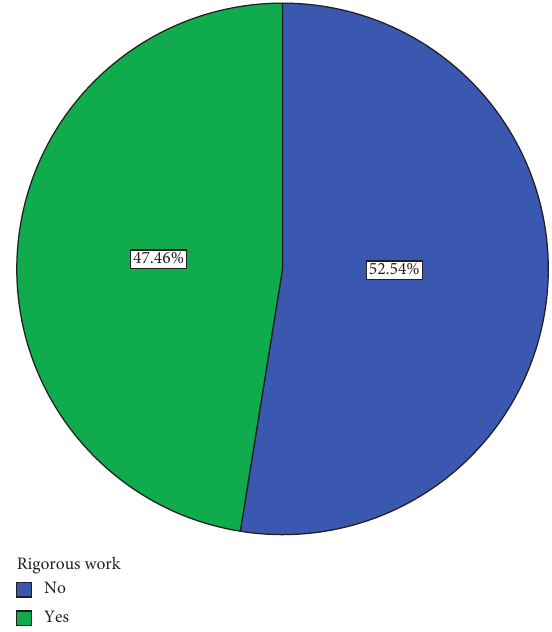
Figure 10: Distribution of whether participants’ work involved rigorous activities.